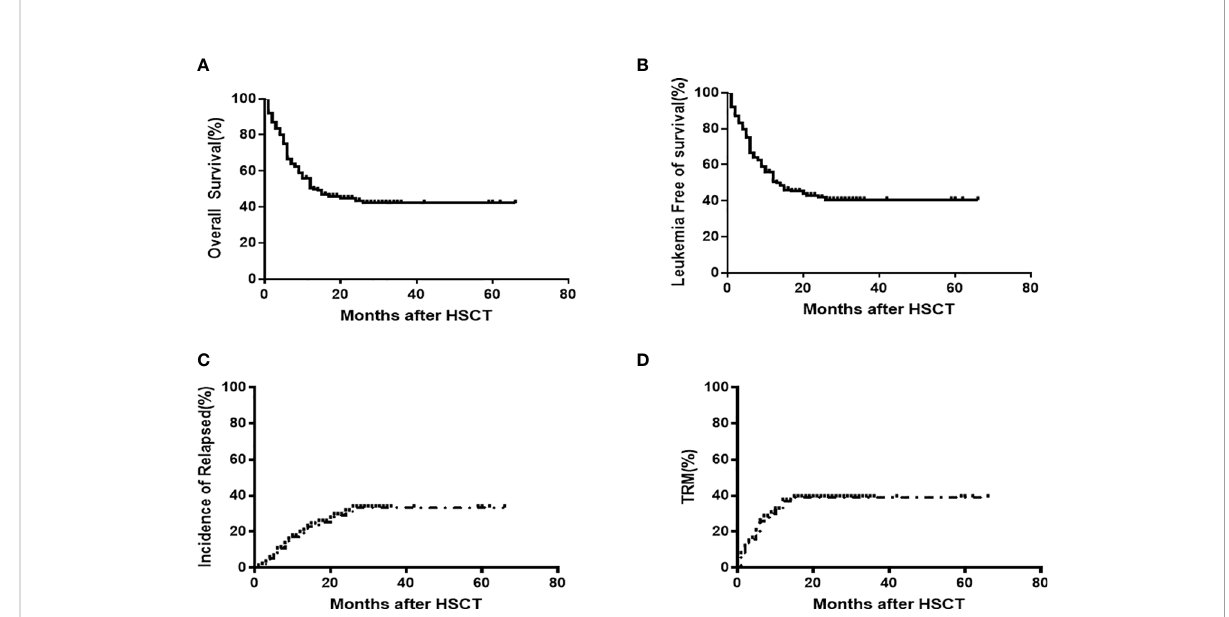
FIGURE 2 OS (43.8% [95%CI,39.7-48.0]) (A) and LFS 42.1% [95%CI,38.6-47.8] (B) , CIR(30.0%[95%CI,26.4-34.7] (C) and TRM 38.5%[95%CI,34.7-42.3] (D) outcomes following allo-HSCT2 among 199